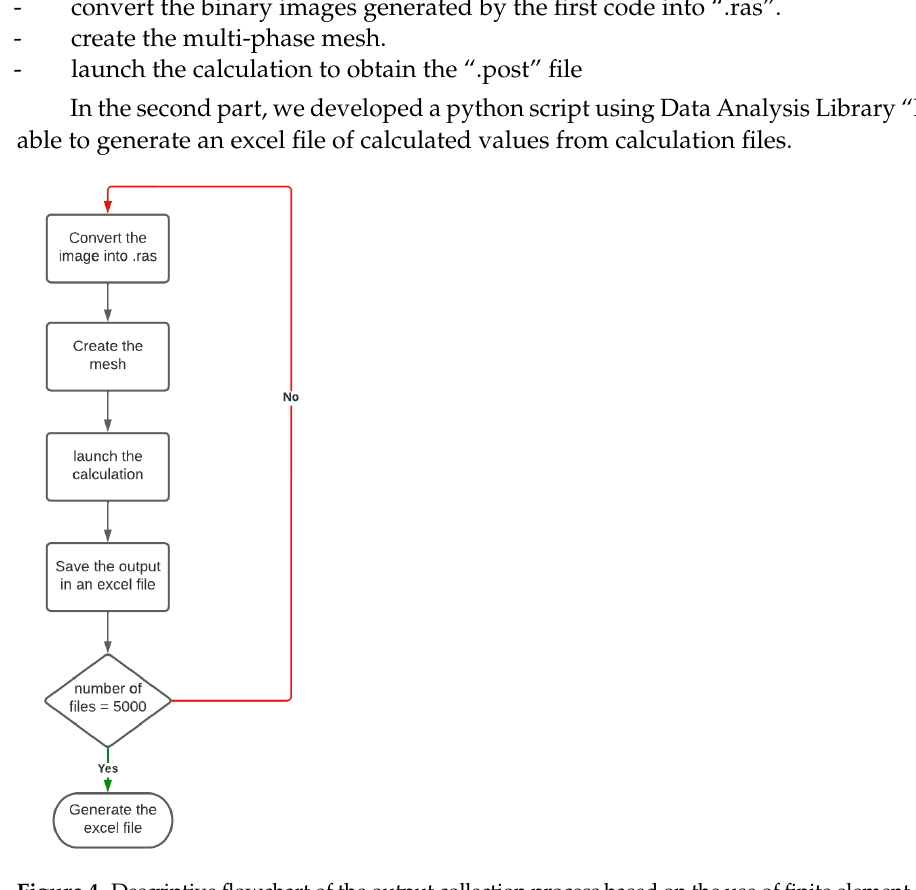
Figure 4. Descriptive flowchart of the output collection process based on the use of finite element